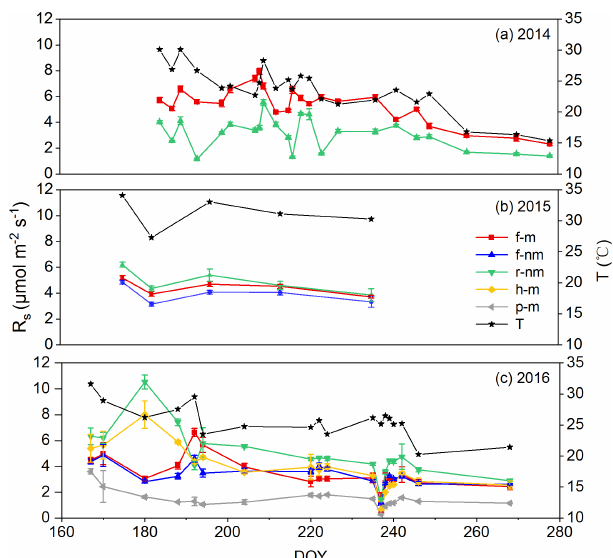
Figure 3. Spatio-temporal variation in soil respiration in mulched and non-mulched fields over the 3 years. The whiskers represent the standard deviation of three replicate R s measurements (f-m, h- m, and p-m represent furrow, planting hole, and plastic mulch in the mulched field, respectively; f-nm and r-nm represent the furrow and ridge in the non-mulched field, respectively; T represents soil temperature).